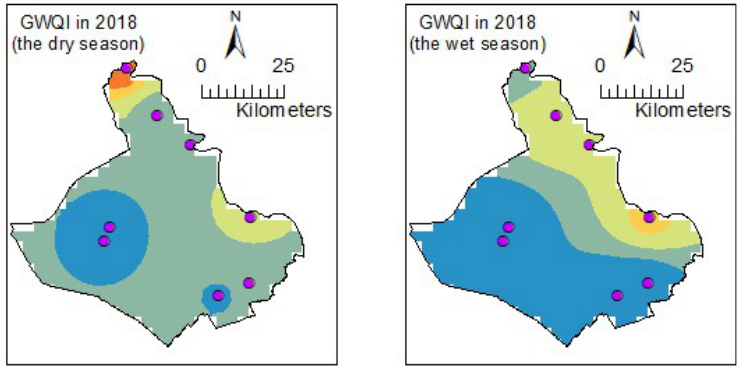
Figure 9. The groundwater quality index (GWQI) in An Giang. Notes: < 50 (Excellent water), 50–100 (Good water), 100–200 (Bad water), 200–300 (Very bad water), and > 300 (Unsuitable for drinking).